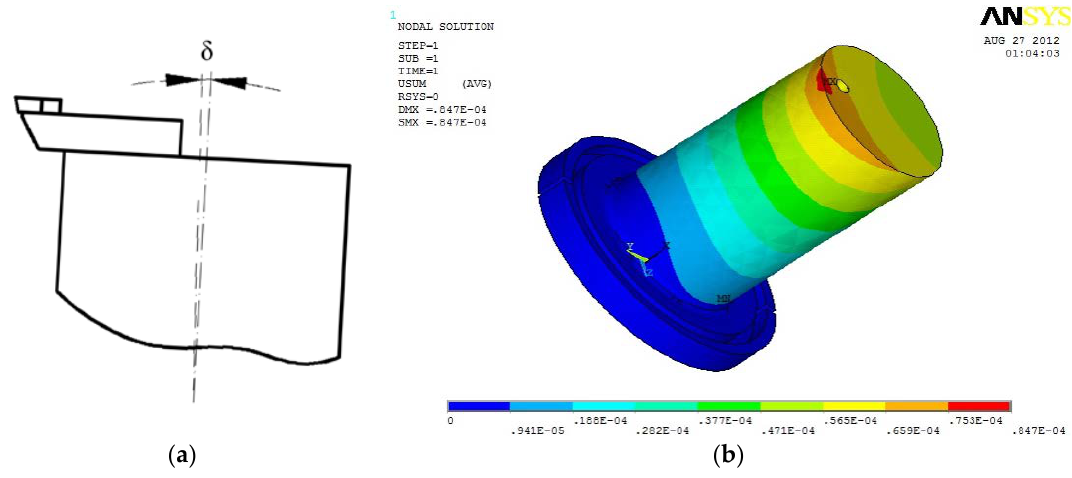
Figure 13. Force analysis of ultrasonic horn; ( a ) Schematic diagram of force analysis; ( b ) Finite element analysis of the force on horn. Micromachines 2018 , 9 , x FOR PEER REVIEW